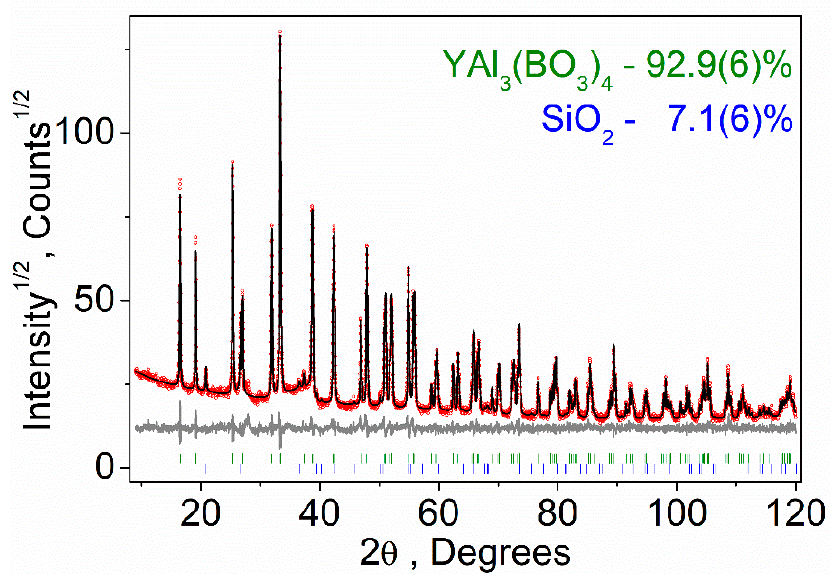
Figure 2. Difference Rietveld plot of YAl 3 (BO 4 ) 3 with small amount of SiO 2 impurity, which was appeared after grinding in agate mortar.